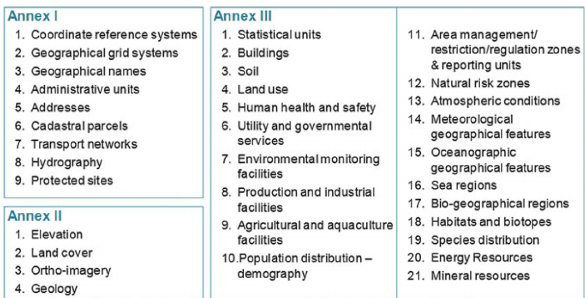
Figure 1. INSPIRE spatial data themes, divided in three Annexes (source: European Commission,